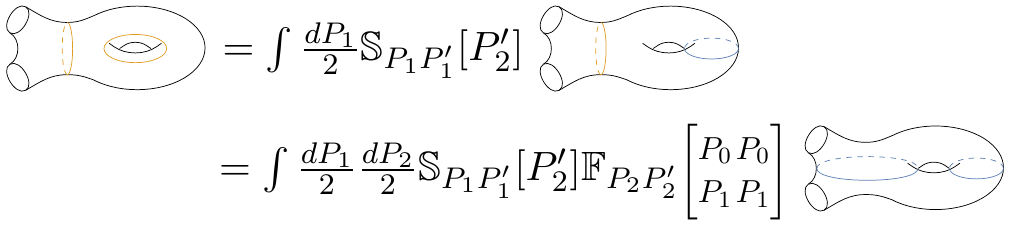
Figure 6 . The sequence of Moore-Seiberg moves to express the OPE channel torus two-point block in terms of necklace channel blocks: a modular S, followed by a fusion